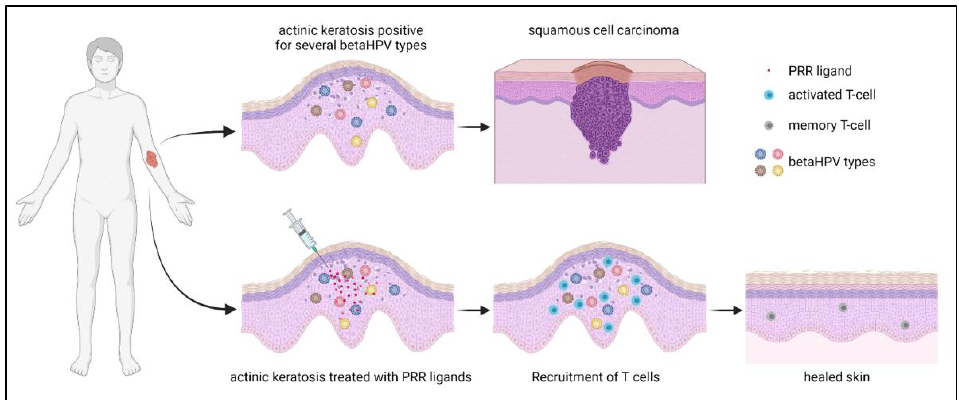
Figure 2. Graphical illustration of an hypothetical activation of an innate immunity-driven in situ autovaccination strategy against the patient’s “own” betaHPV types to induce protective T cell-mediated immunity and to prevent cSCC development (data from [88]).